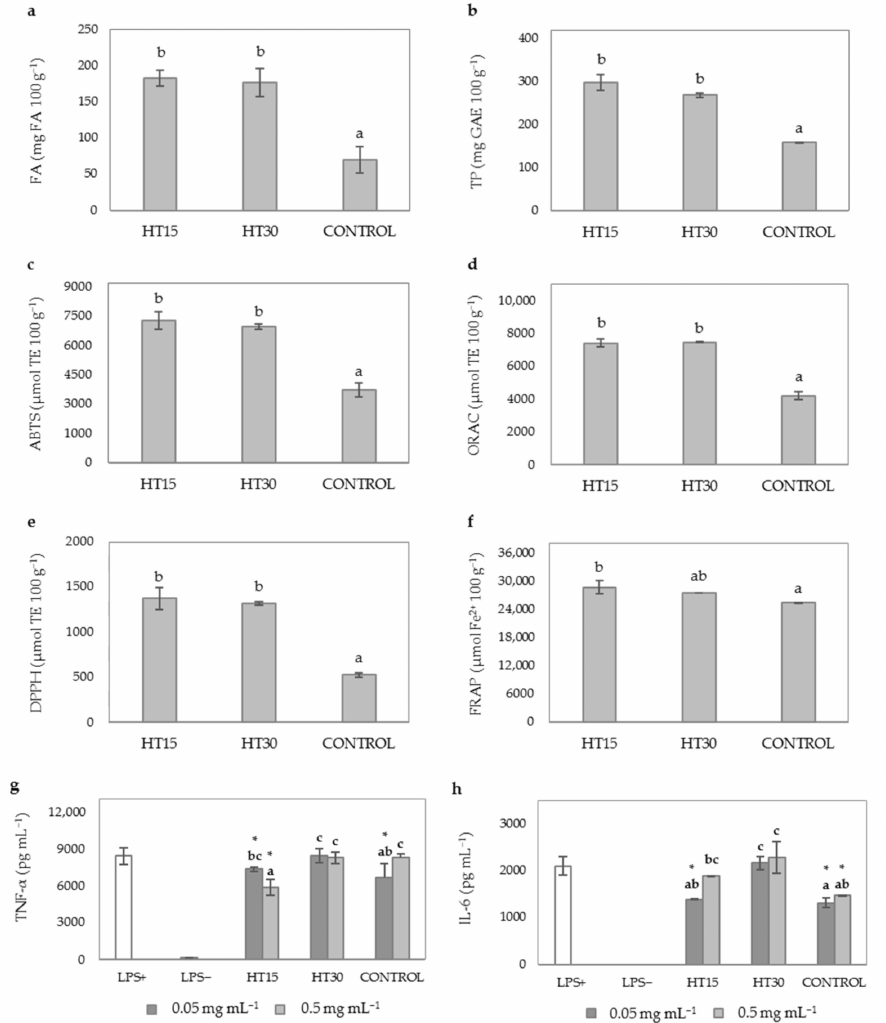
Figure 2. Evaluation of time during HT on phenolic compounds content, TAC and AIA of WB hydrolysates. ( a ) FA content (mg 100 g − 1 ); ( b ) TP content (mg GAE 100 g − 1 ); ( c ) ABTS scav- enging activity ( µ mol TE 100 g − 1 ); ( d ) ORAC ( µ mol TE 100 g − 1 ); ( e ) DPPH scavenging activity ( µ mol TE 100 g − 1 ); ( f ) FRAP ( µ mol Fe 2+ 100 g − 1 ); ( g ) TNF- α levels (pg mL − 1 ); ( h ) IL-6 levels (pg mL − 1 ). Sample identification: hydrolyzed WB without HT (CONTROL), hydrothermal